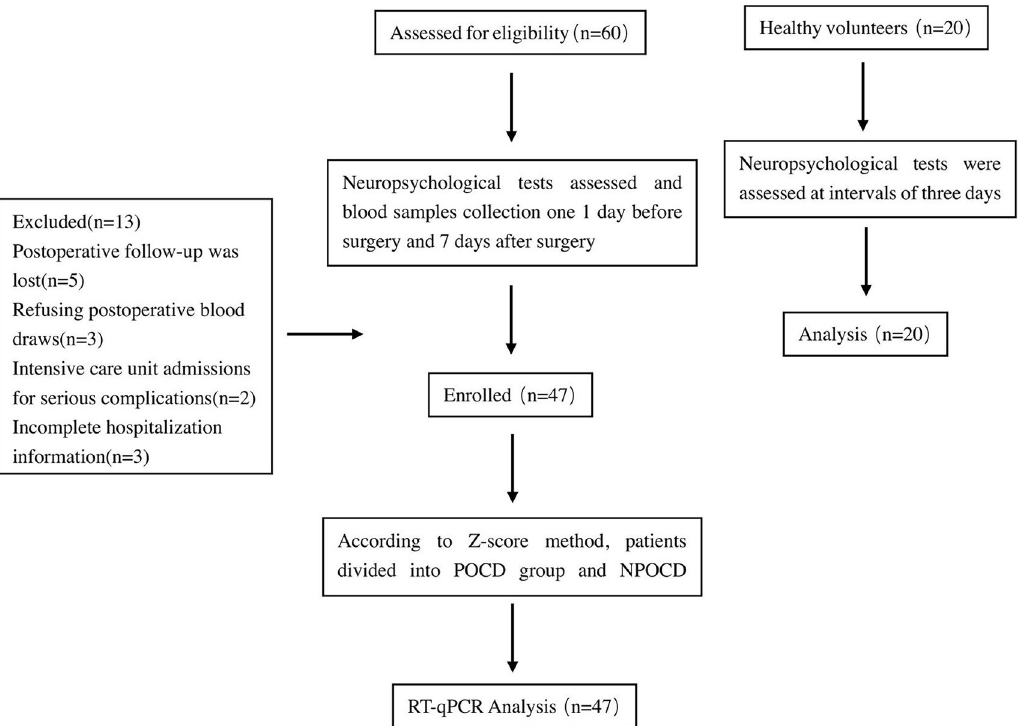
Fig 1. Study flow chart. RT-qPCR: quantitative real-time polymerase chain reaction; POCD: post-operative cognitive dysfunction.